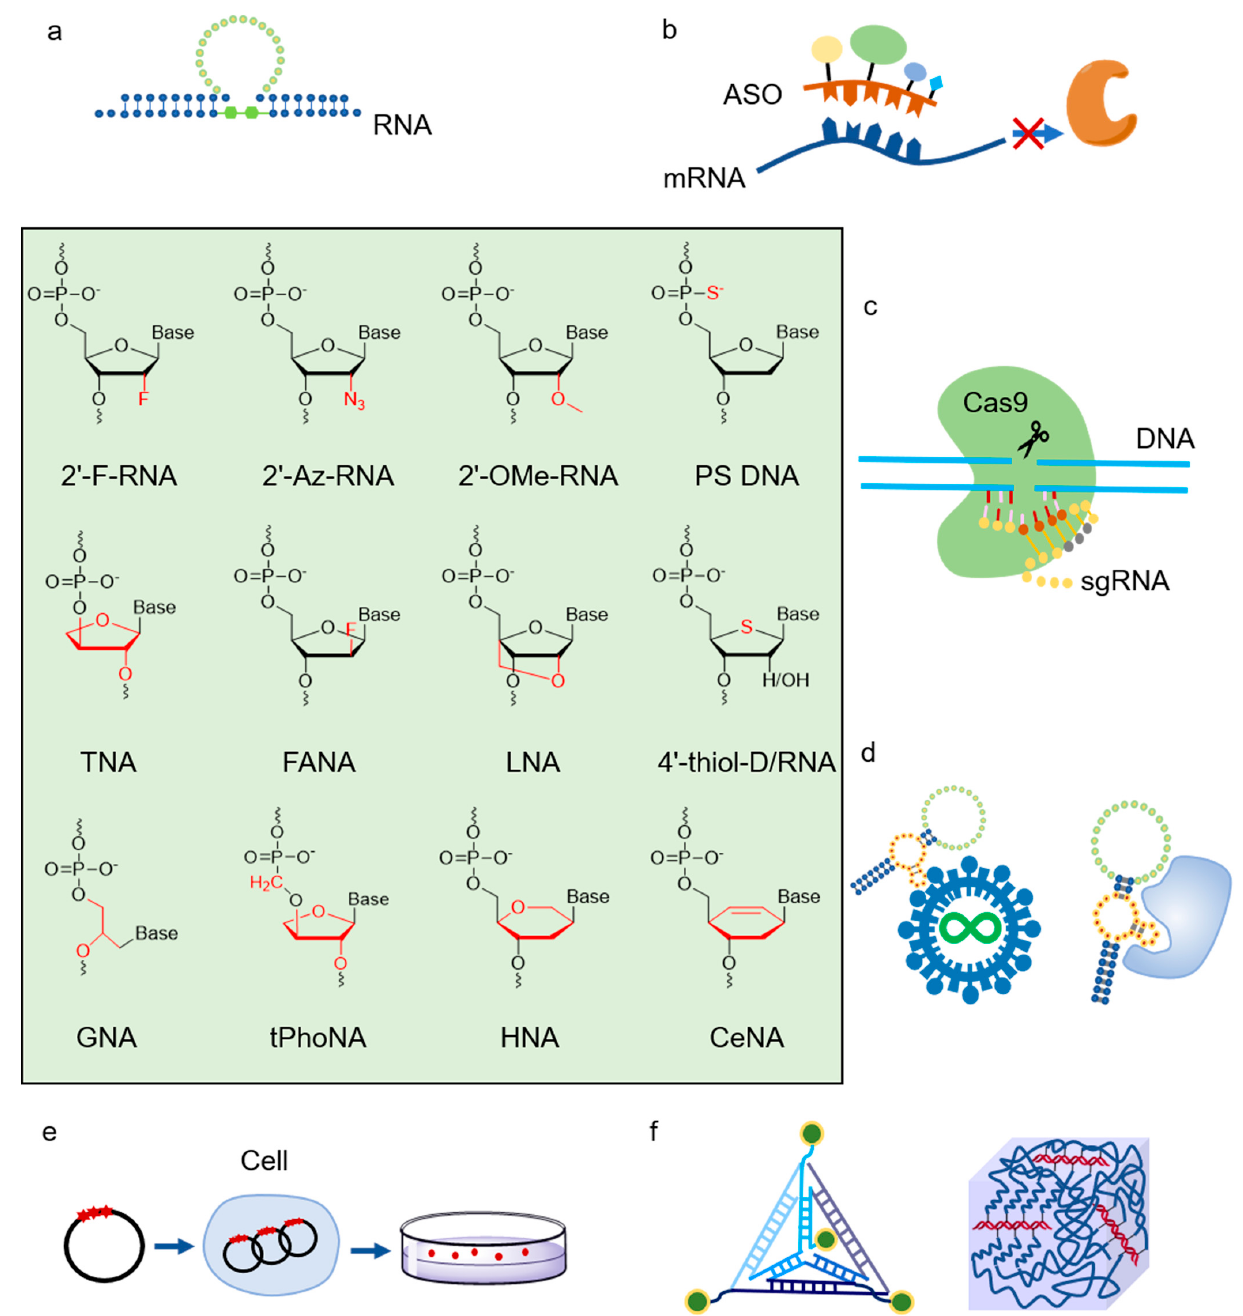
Figure 6. Application of XNAs and XNAPs. Modifications endow XNAs with expanded structural and functional diversities, and XNAPs further broaden the application scope of XNAs. ( a ) XNAzymes; ( b ) modified antisense oligonucleotides; ( c ) modified guide RNAs for CRISPR/Cas9 system; ( d ) XNA aptamers; ( e ) genetic information storage in living organisms; ( f ) XNA materials. Antisense oligonucleotides (ASOs) are short nucleic acids that can